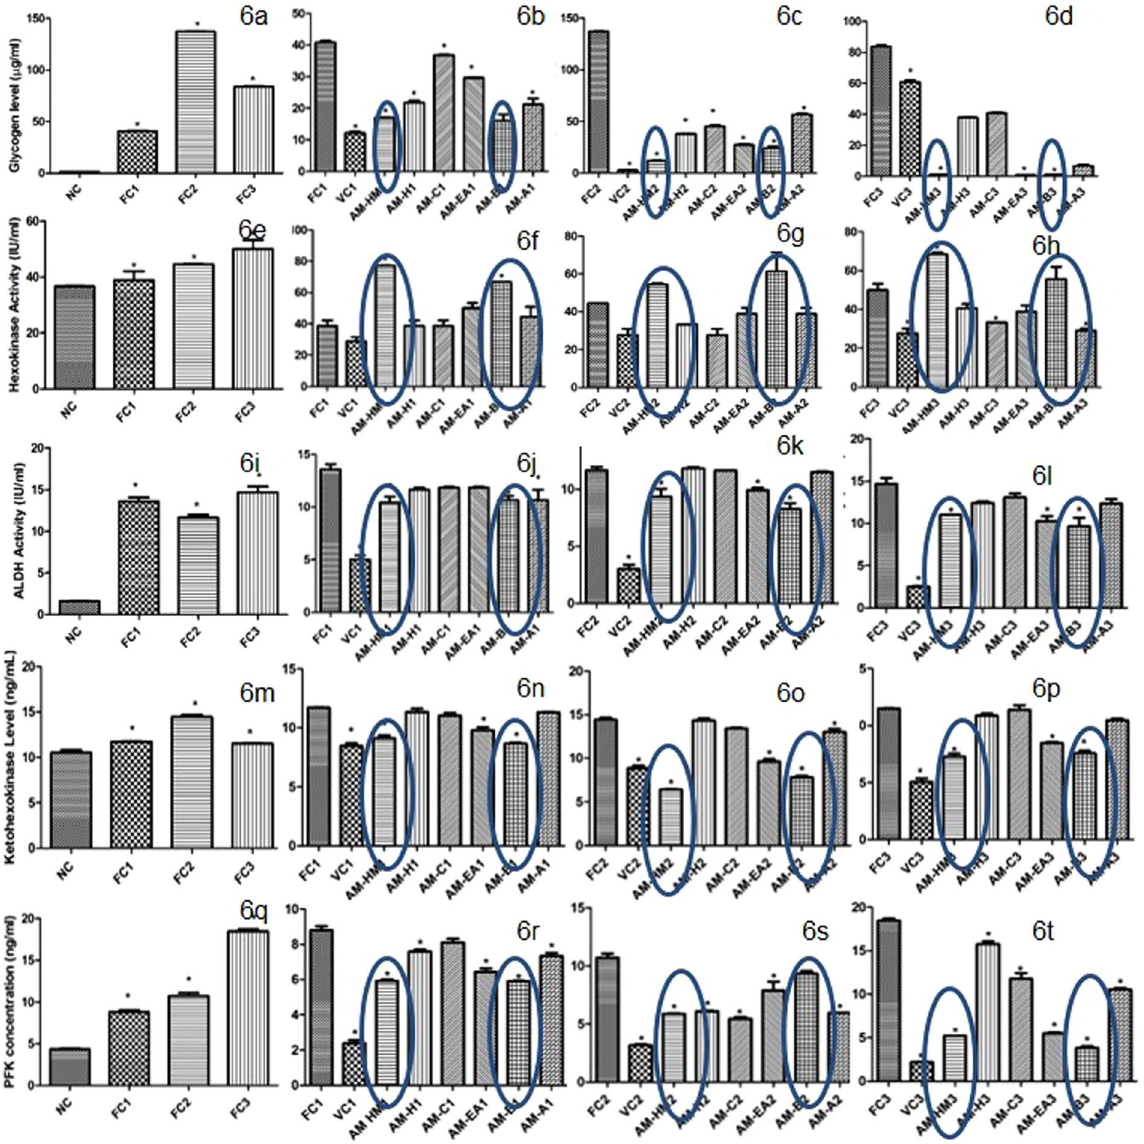
Figure 7. Effect of AM-HM on the molecular markers of IR in HepG2 when they are grown in fructose-rich media. Treatment of HepG2 cells grown in media either without glucose (NC) or with 0.55 mM fructose(FC1) or with 1 mM fructose (FC2) or with 1 mM fructose + 0.1 µ M Insulin (FC3) with AM-HM (75 µ g/ml), AM-H (75 µ g/ml), AM-C (75 µ g/ml), AM-EA (75 µ g/ml), AM-B (75 µ g/ml) or AM-A (75 µ g/ml) for 48 hours. The AM-HM and AM-B reduced the activities of molecular markers of insulin resistance, lipogenesis and inflammation- PI3K (ng/ml), signal transducer and activator of transcription-3 (mAU), mitochondrial target of rapamycin, mTOR (mAU), hypoxia-induced factor, HIF-1 α vascular endothelium growth factor(ng/ml), vascular endothelial growth factor, VEGF, (pg/ml) and tumor necrosis factor, TNF- α (pg/ml), a marker of inflammation and insulin resistance in FC1 and FC2. The effect of AM-HM and AM-B was augmented by insulin in FC3. Each value is the mean ± SD of n = 3. * p < 0.05, vs control using student- t